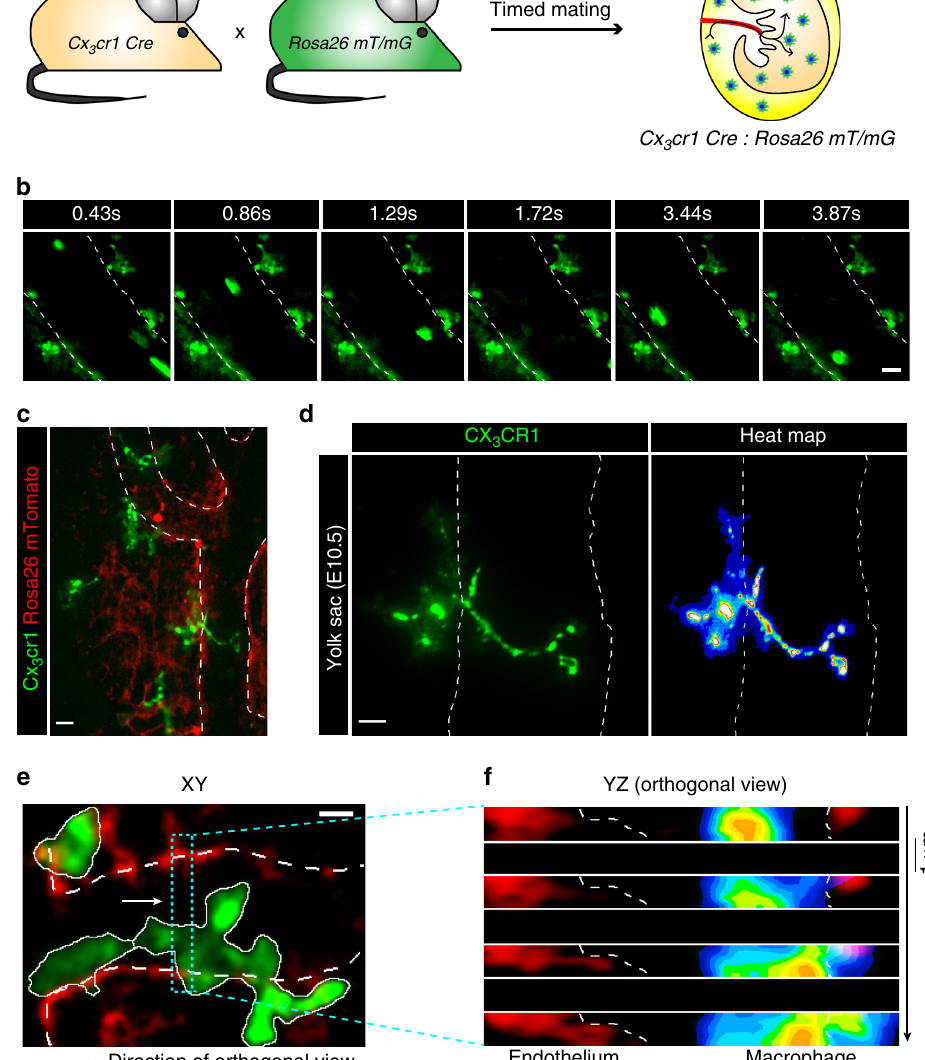
Fig. 3 Traf fi cking is associated with cellular morphology. Intravital spinning disc microscopy of YS vasculature in E10.5 Cx 3 cr1 Cre : Rosa26 mT/mG embryos. a Schematic graph for the Cx 3 cr1 Cre : Rosa26 mT/mG mouse model. b Image series of CX 3 CR1 GFP+ (green) YS pre-macrophages; direction of fl ow from top to bottom (from Supplementary Movie 7). c – f Dendrite-shaped CX 3 CR1 GFP+ macrophages (green) with intravascular protrusions ( c , d ) further illustrated by multiplanar reconstructions in XY ( e , from Supplementary Movie 8) and orthogonal YZ views including heat map ( f ); endothelium (mTomato, red). Scale bars are 20 µ m ( b , c , e ), 10 µ m ( d